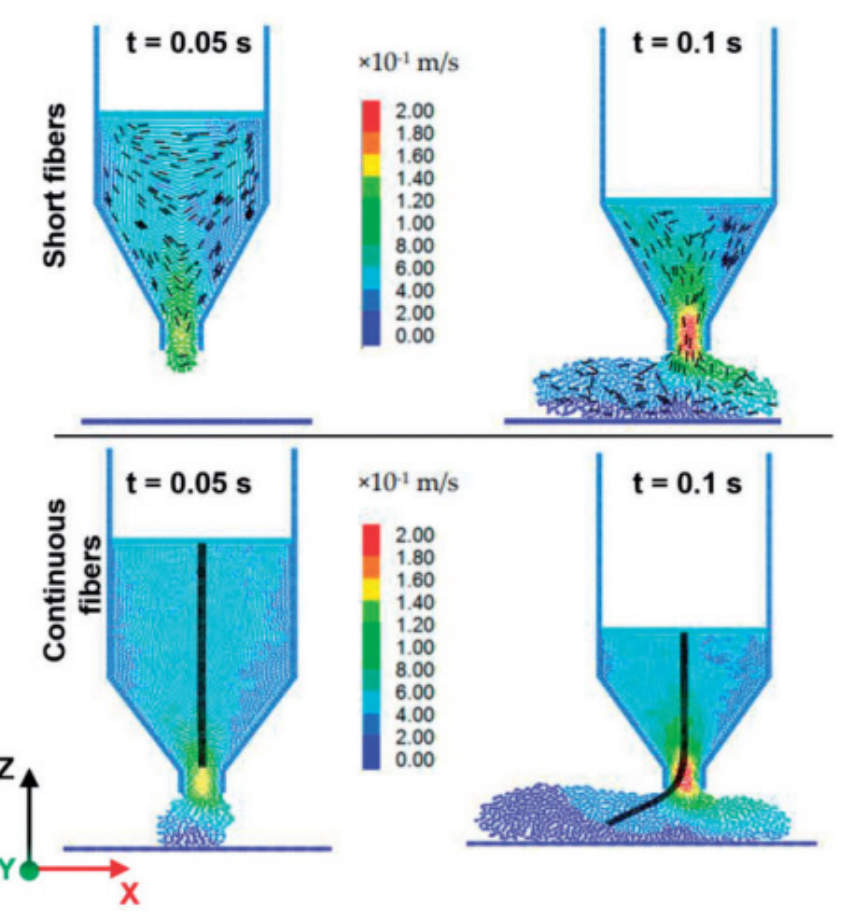
Figure 4. Velocity profiles for short and continuous fiber-reinforced composites. Reprinted with permission from reference [40], Copyright 2017, MDPI.